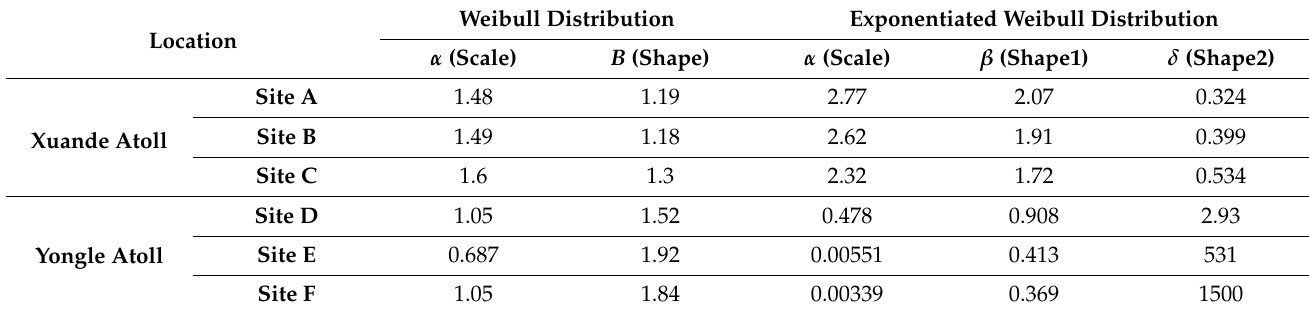
Table 5. Fitted parameters using different models at six selected near-island